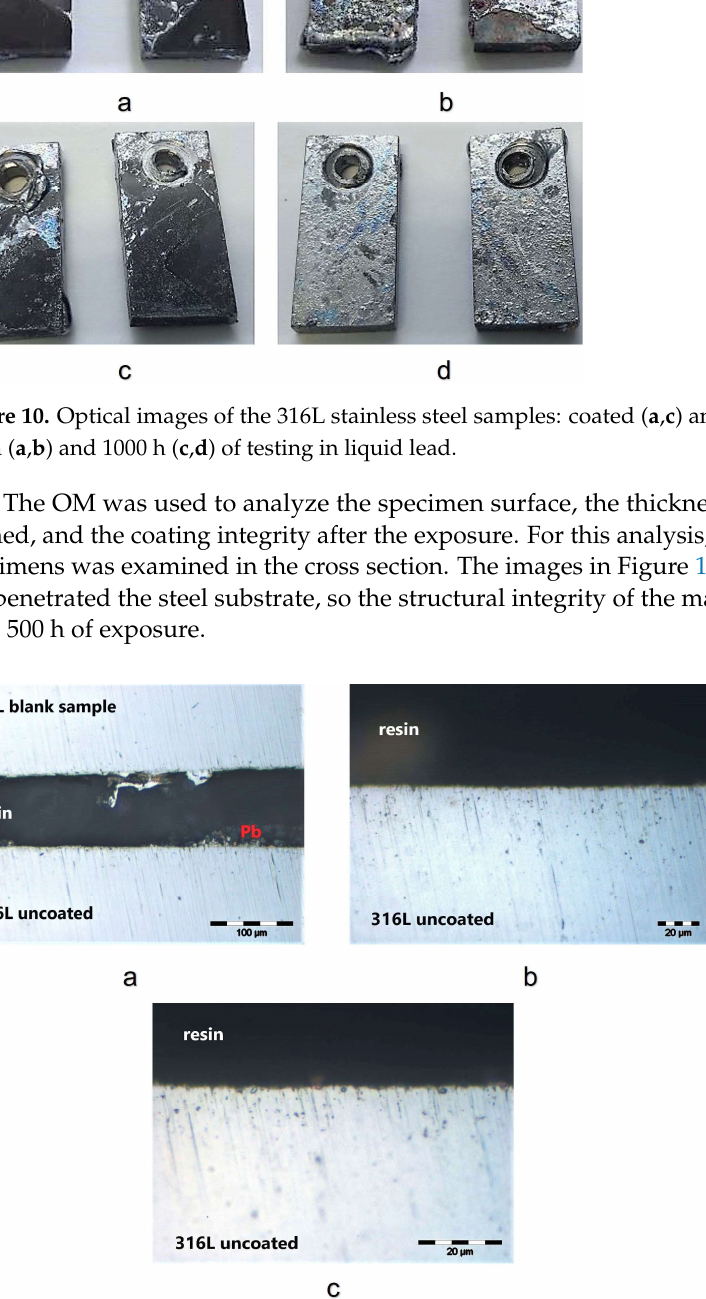
Figure 12. Cross section of an AISI 316L uncoated specimen after being tested for 1000 h in liquid lead at different magnifications: 200× ( a ), 1000× ( b ), and 2000× ( c ).